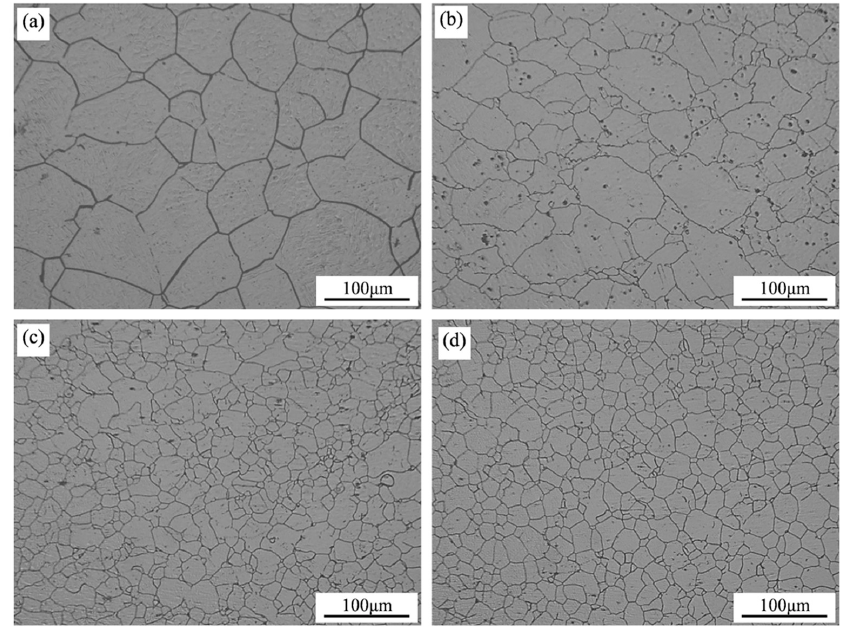
Figure 8. Microstructure of S280 steel under different strains at a deformation temperature of 1150 °C and strain rate of 1 s − 1 : ( a ) 𝜀 = 0 ; ( b ) 𝜀 = 0.11 ; ( c ) 𝜀 = 0.43 ; ( d ) 𝜀 = 1.2 .